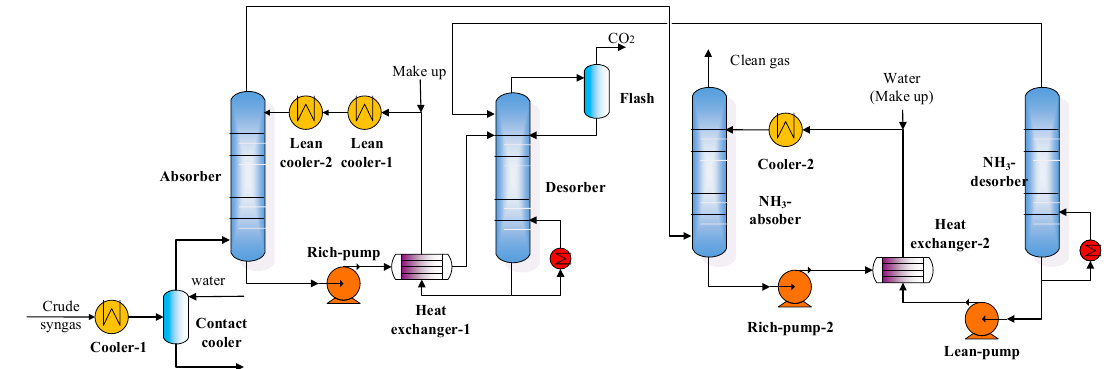
Figure 5. Simplified simulation flowsheet of the CAP technology.